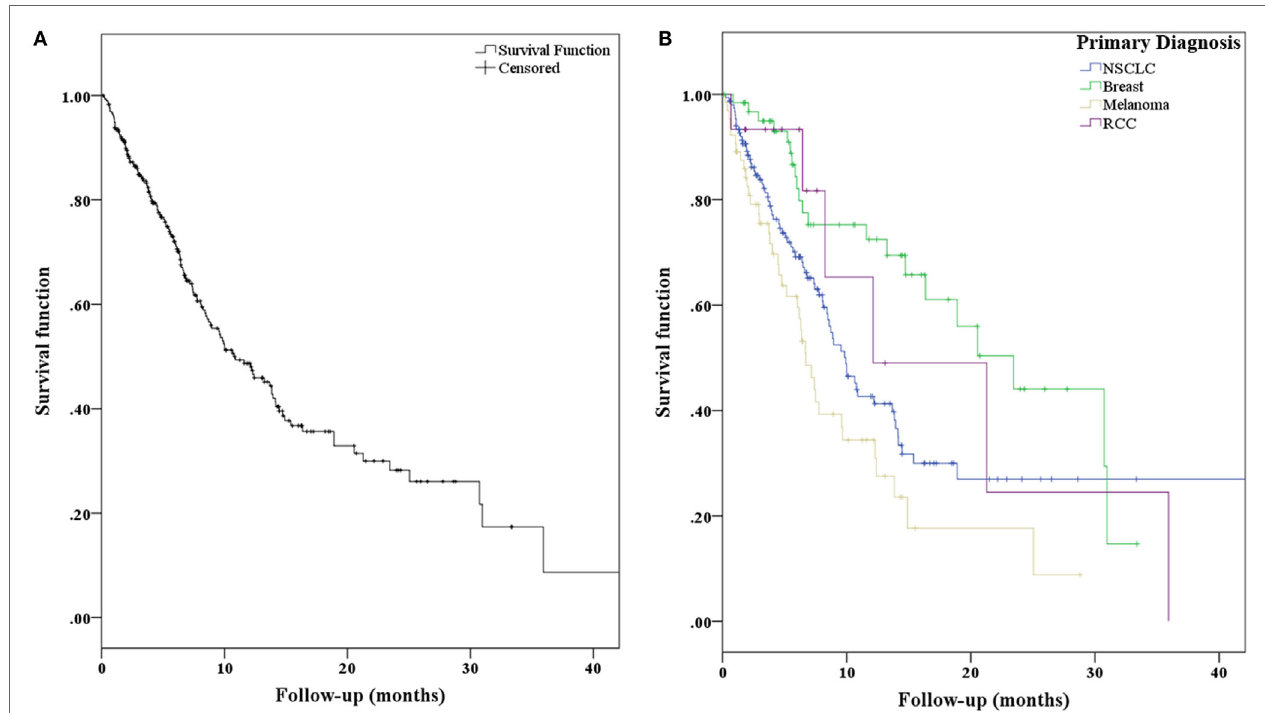
FigUre 2 | (a) Kaplan–Meier curves representing overall survival for all patients and (B) separated with respect to primary